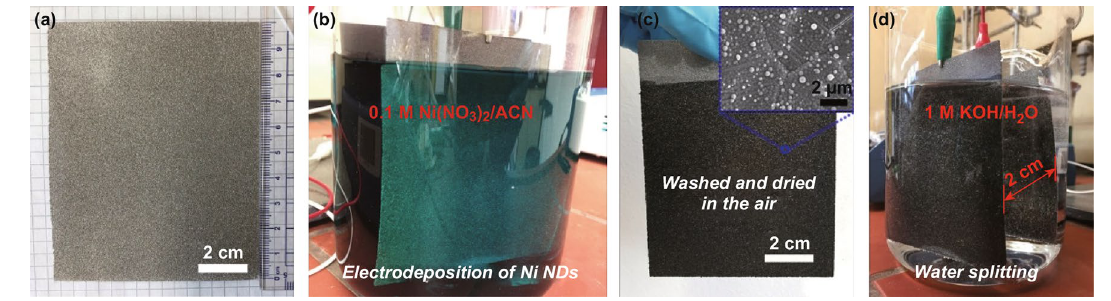
Fig. 5 Photographs of the preparation and application process of large‑area NiO/NiNDs@NF electrodes: a Ni foam that is 80 cm 2 . b Electro‑ deposition process of NiNDs on NF. c The obtained NiO/NiNDs@NF electrode that has an effective geometric surface area of 70 cm 2 (inset is an SEM image). d Generation of H 2 and O 2 bubbles on the NiO/NiNDs@NF electrode with a constant current density of 13 mA cm −2 (see SI for a video)